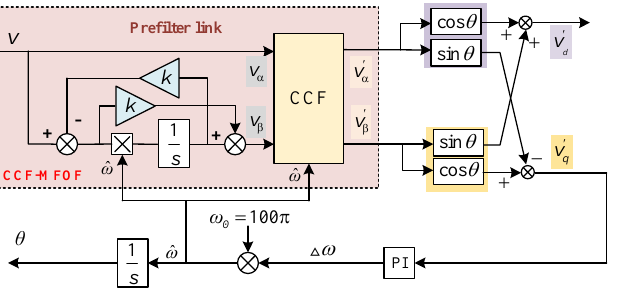
Figure 5. Control block diagram of CCF-MFOF-PLL.